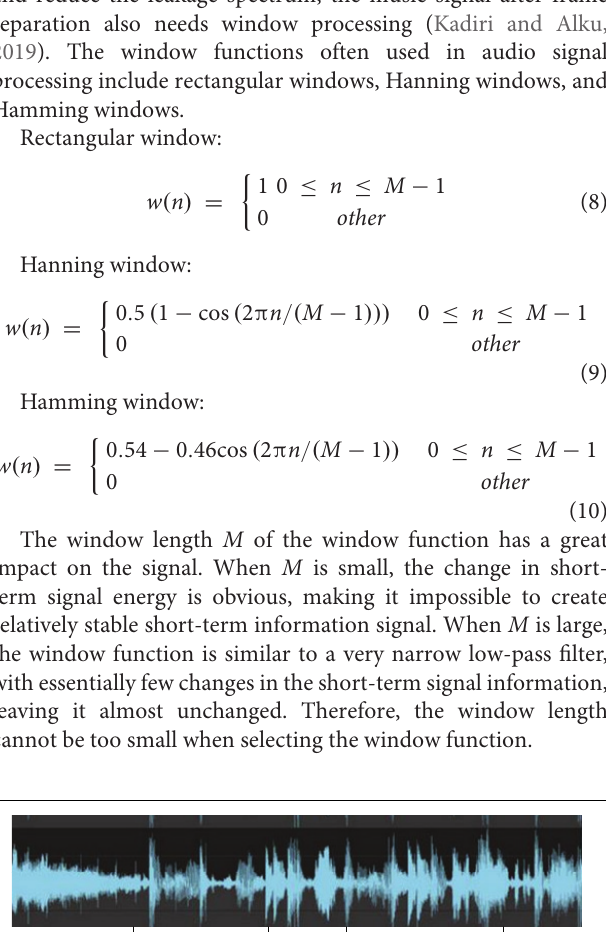
FIGURE 2 | Comparison between time-domain waveform after pre-emphasis of pipa music segment and the original time-domain waveform.